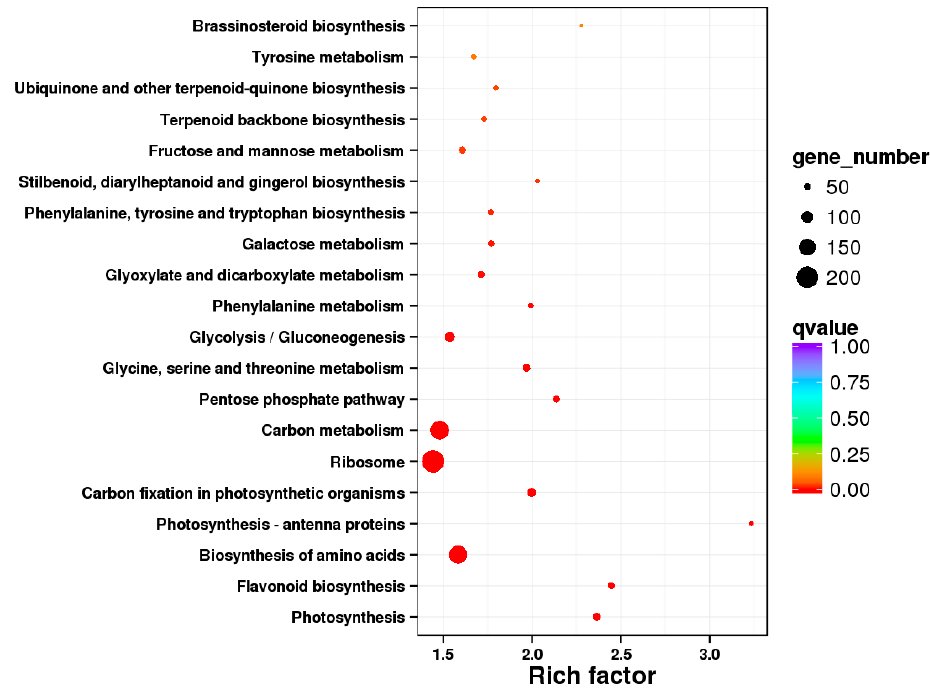
Figure 5. Bubble plot of the Kyoto Encyclopedia of Genes and Genomes (KEGG) database pathway enrichment of the DEGs. The first 20 enriched pathways are shown. Table 5. Putative structural genes involved in anthocyanin biosynthesis identified from transcriptome data.